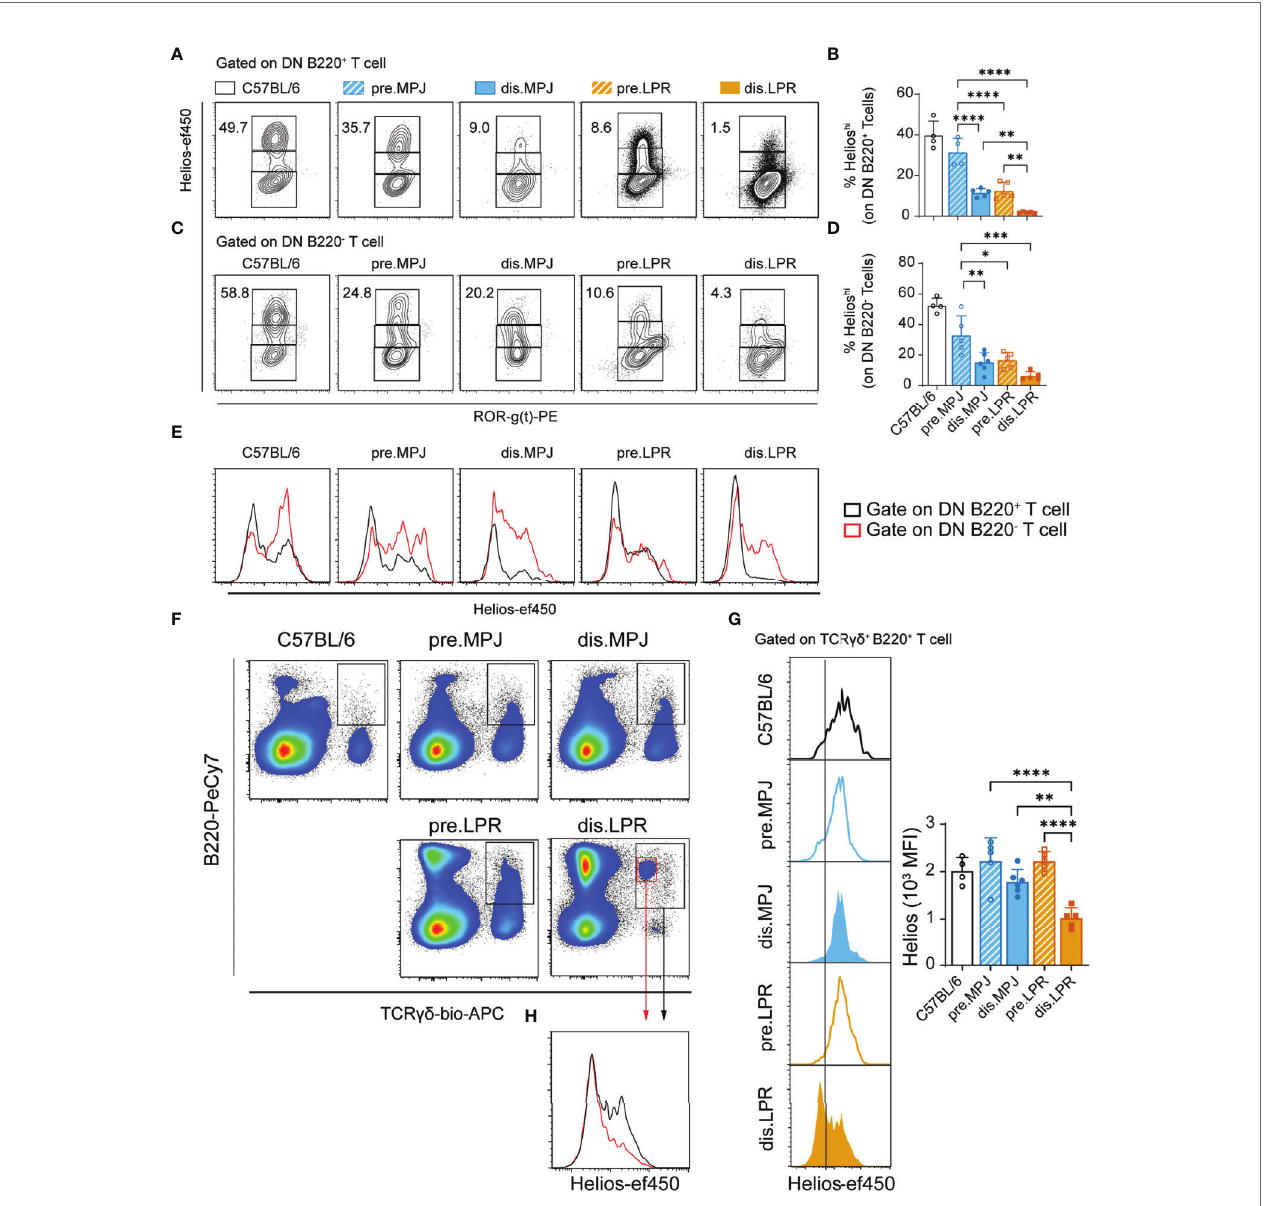
FIGURE 6 | Helios levels in different T-cell subsets from MPJ and LPR mice. (A) Representative fl ow cytometry plots pregated on splenic DN B220 + T cells (CD3 + TCR gd − B220 + CD4 − CD8 − ), in which three different gates are indicated based on Helios expression (Helios low/mid/hi ). (B) Helios hi frequencies on DN B220 + T cells. (C) Representative fl ow cytometry plots pregated on splenic DN B220 − T cells (CD3 + TCR gd − B220 − CD4 − CD8 − ). (D) Helios hi frequencies among DN B220 − T cells. (E) Representative histograms of Helios in DN T-cell populations: DN B220 + (black) and DN B220 − (red). (F) Representative fl ow cytometry plots pregated on splenic CD3 + T cells, indicating the TCR gd + B220 + gates. (G) Representative Helios histograms gated on TCR gd + B220 + (left) and their quanti fi cation (MFI: right). (H) Representative Helios histograms comparing two distinct TCR gd + B220 + subsets (red and black) from diseased LPR mice. The data represent the mean ± SD: *P < 0.05, **P < 0.01, ***P < 0.001, ****P < 0.0001 for comparisons between MRL animals. One-way ANOVA with a Tukey multi-comparison post-test. Each point represents a single animal: prediseased MPJ (pre.MPJ), n = 5 (A – D, G) ; diseased MPJ (dis.MPJ), n = 6 (A – D, G) ; prediseased LPR (pre.LPR), n = 5 (A – D, G) ; and diseased LPR (dis.LPR), n = 5 (A – D, G)